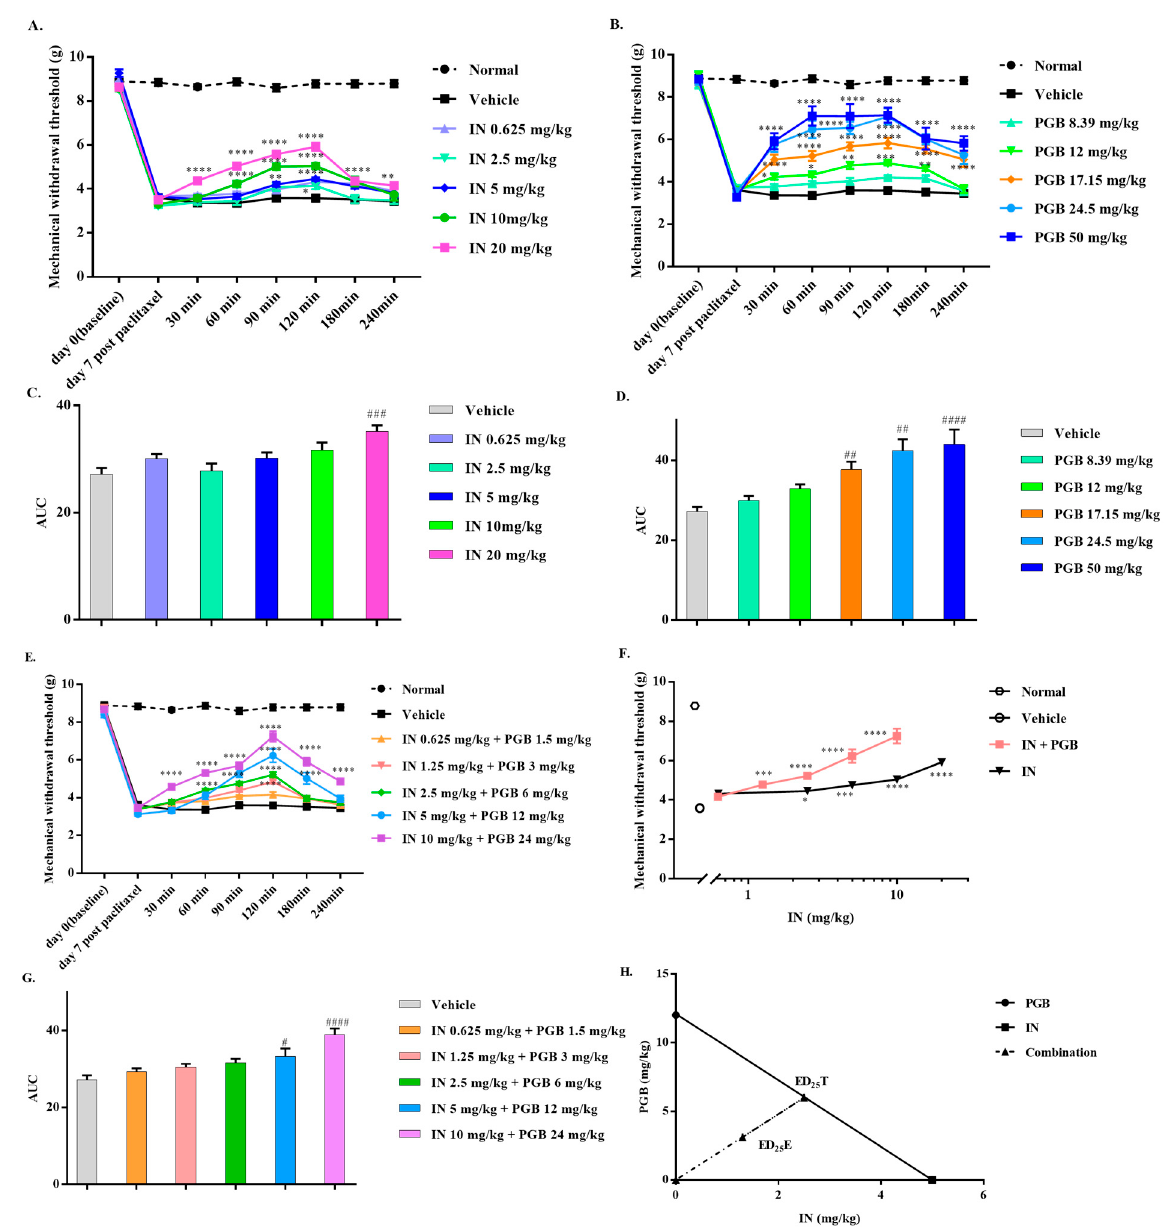
Figure 1. Effect of indomethacin (IN), pregabalin (PGB), and IN-PGB on paclitaxel-induced neuro- pathic pain in mice. Time course of the antiallodynic effects evoked by IN ( A ) and PGB ( B ). The AUC of IN or PGB indicates that they reversed paclitaxel-induced mechanical allodynia in a dose-related manner ( C , D ). Equieffective doses of IN and PGB were administered in combination to reverse mechanical allodynia ( E ). An equieffective combination of PGB and IN made the dose–response curve shift to the left ( F ). Time course effects of the IN-PGB are expressed as the AUC ( G ). The equieffective combination of IN and PGB produced a synergistic effect, as ED 25 E fell below the line of additivity ( H ). For this graph, the derived ED 25 value of IN is plotted on the abscissa, and the ED 25 value of PGB is plotted on the ordinate. * p < 0.05, ** p < 0.01, *** p < 0.001, and **** p < 0.0001 versus vehicle by two-way ANOVA followed by Tukey’s test. # p < 0.05, ## p < 0.01, ### p < 0.001, and #### p < 0.0001 versus vehicle by one-way ANOVA followed by Dunnett’s test. Data are expressed as mean ± S.E.M., n = 8/group.